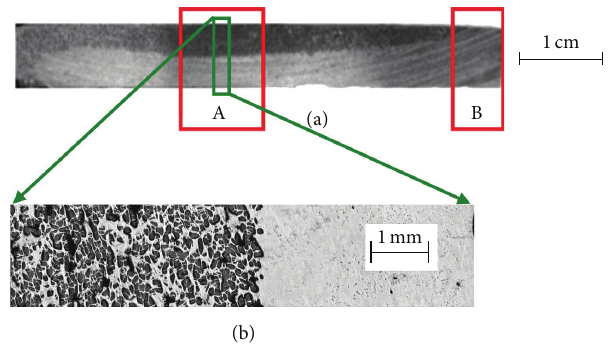
Figure 8: Macrostructure (a) and microstructure in the middle of area A (b) of a one-side reinforced